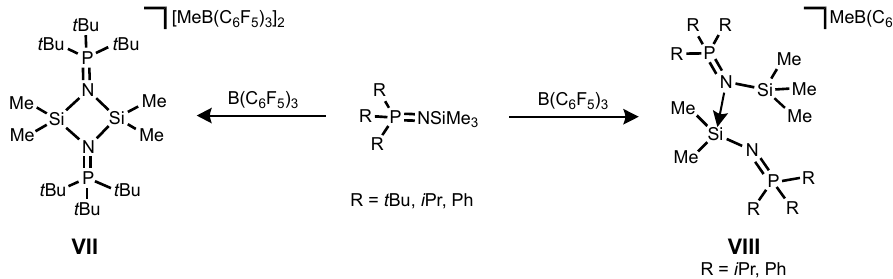
Scheme 1. Syntheses of silylium ions VII and VIII via a methyl abstraction with B(C 6 F 5 ) 3 .